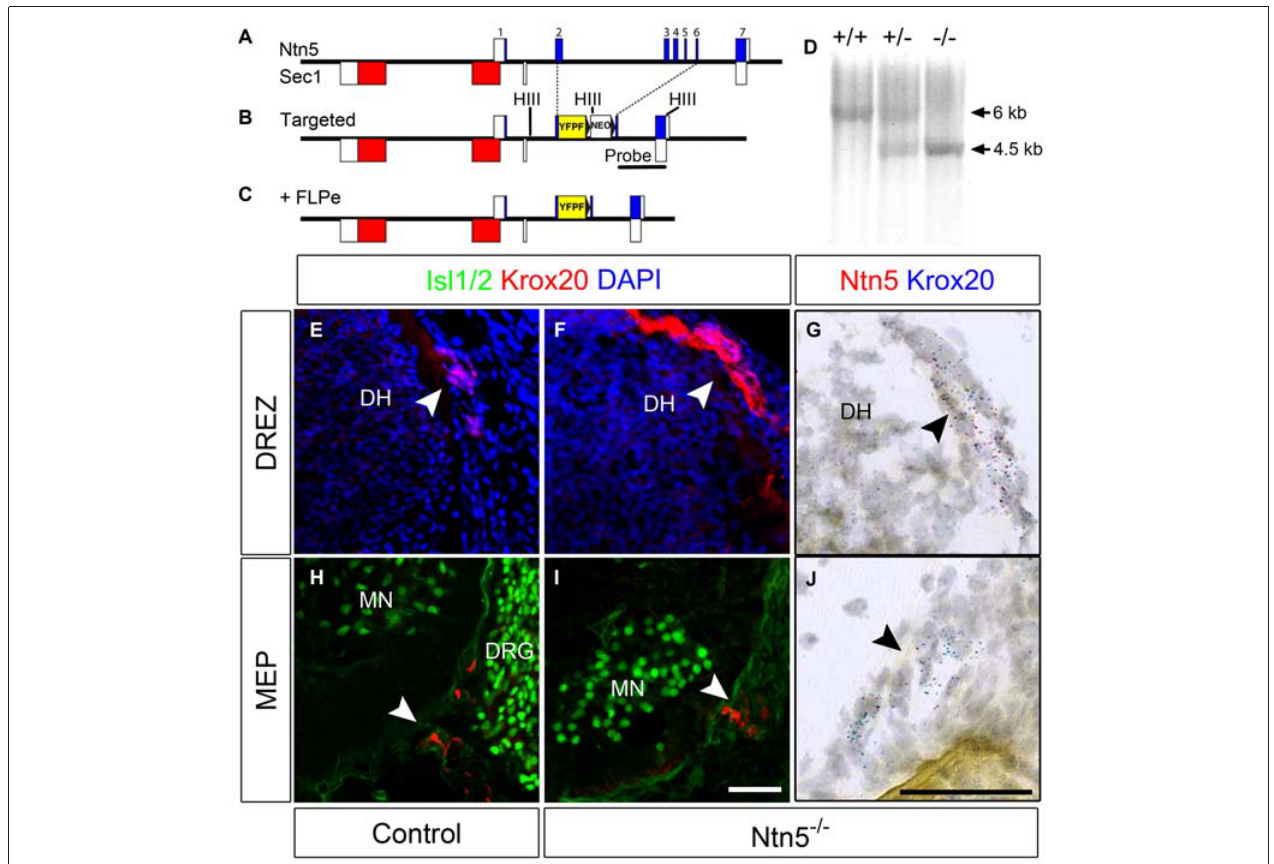
FIGURE 2 | BCC develop in the absence of Ntn5 . Ntn5 was deleted without disrupting the Sec1 gene on the opposite strand. A cassette encoding a farnesylated YFP and a FRT-flanked neomycin resistance gene was knocked into the Ntn5 locus so that YFP was fused to the 5th base pair of exon 2, while the remainder of exons 2–6 was deleted. Open boxes indicate untranslated regions of exons (A,B) . Subsequent breeding to FLPe-expressing mice removed the neomycin cassette (C) . Mice were genotyped using primers to exons 3 and 4 to detect wild type alleles and with primers to intron 1 and GFP to detect the mutant allele, (A,C) . Homologous recombination was verified by Southern blot analysis using a probe (indicated in B ) to detect a Hind III fragment (sites in B , HIII) shifted from 6–4.5 kb (D) . Krox20-positive BCC were still present at the DREZ and MEP in Ntn5 mutant embryos, as detected by immunoflouorescence and in situ hybridization (E13.5, E–J ), while Ntn5 transcripts detected by ISH were virtually eliminated (G,J) . DH, dorsal horn of the spinal cord; MN, motor neurons; DRG, dorsal root ganglia. Scale bar is 50 µ